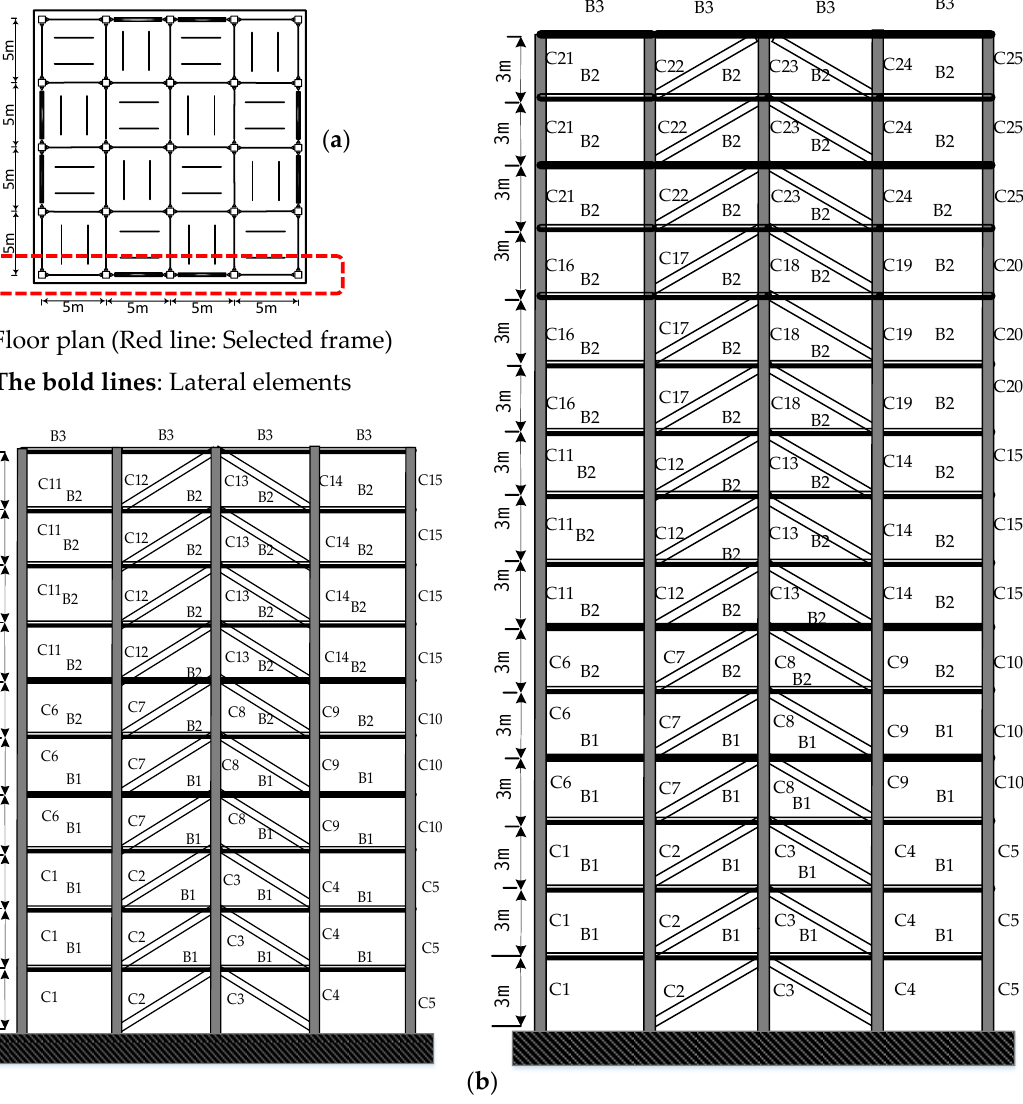
Figure 2. ( a ) Plan of structures and ( b ) topology and grouping details of frames. Table 3. Fundamental periods of structures